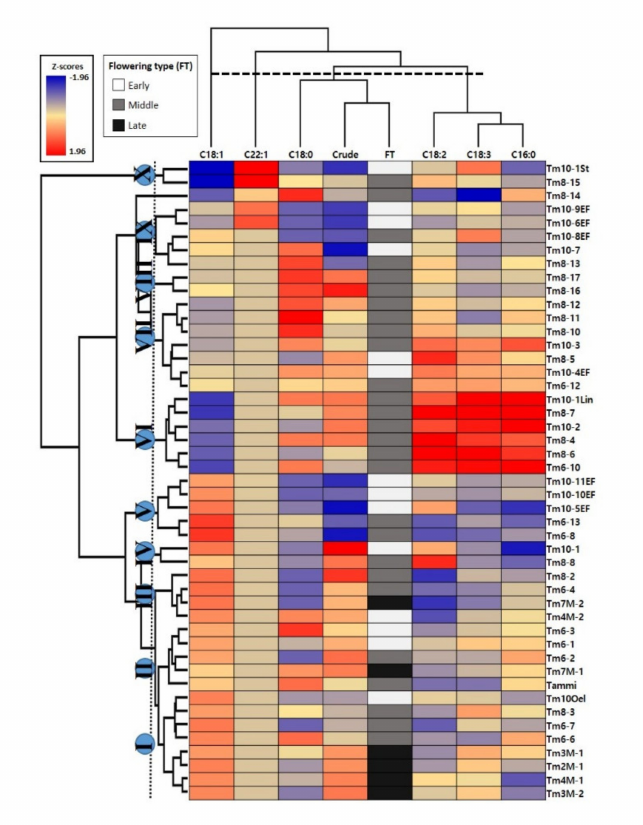
Figure 5. Hierarchical cluster analysis of the 47 rapeseed lines according to their flowering time, crude fat, and fatty acid